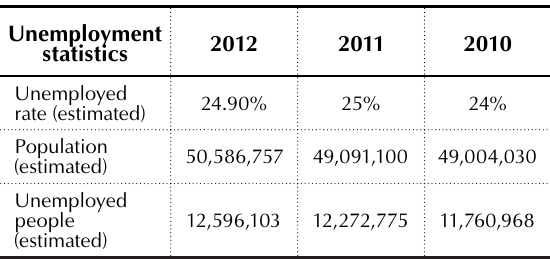
Table 2. Unemployment statistics of South Africa Source: Statistics South Africa (2011).